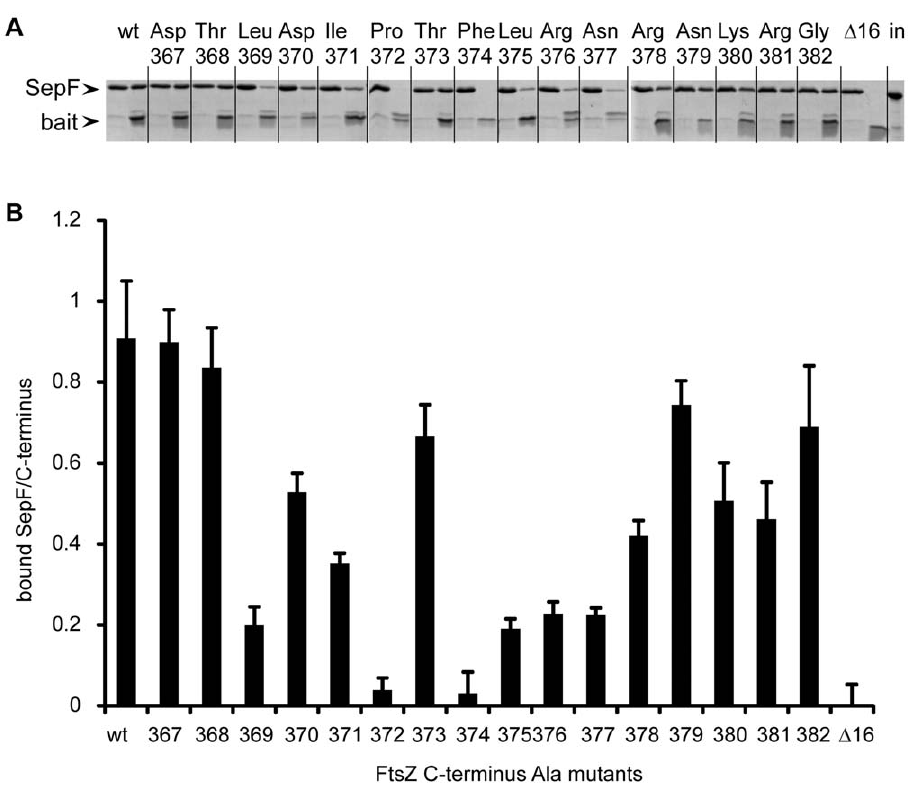
Figure 4. Alanine scanning of the FtsZ C-terminus. (A) Series of three gels from a representative pull down experiment using Halo-ZC (wt), Halo Z D C16 ( D 16) and a series of HaloZC Ala constructs (mutated residue indicated). For each pull down the flow-through (left side) and eluate fractions (right side) were loaded on the gel. The last lane is a loading control containing an equivalent amount of input SepF material. (B) Ratio of eluted SepF over eluted bait protein as determined by densitometric scanning of gels as shown in (A). Three independent experiments were analyzed, error bars indicate standard deviation.